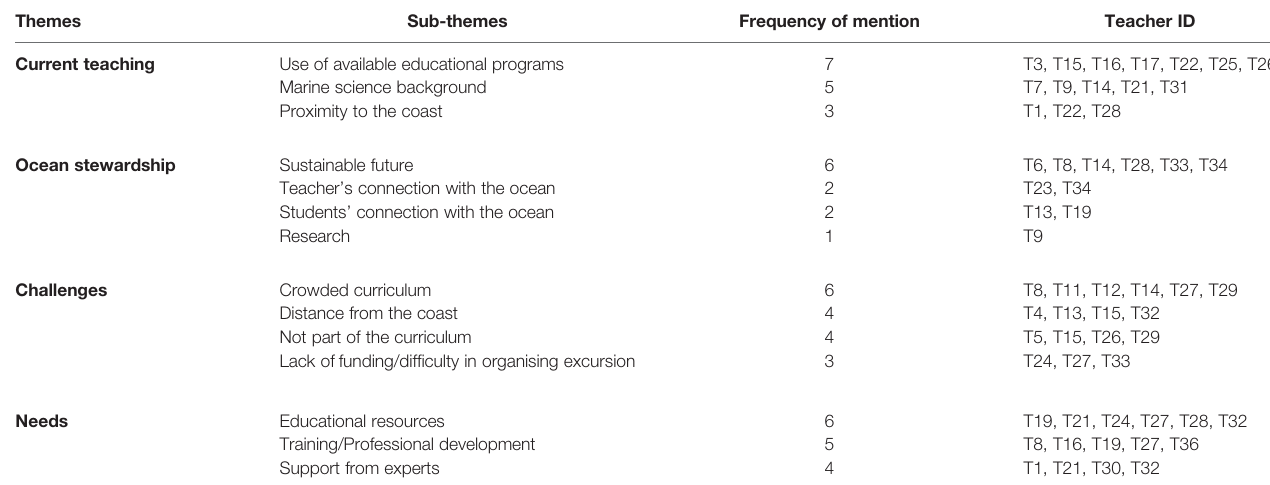
TABLE 4 | Themes and frequency of mention for each speci fi c sub-theme coded based on teacher ’ s perceptions on marine science education in southern